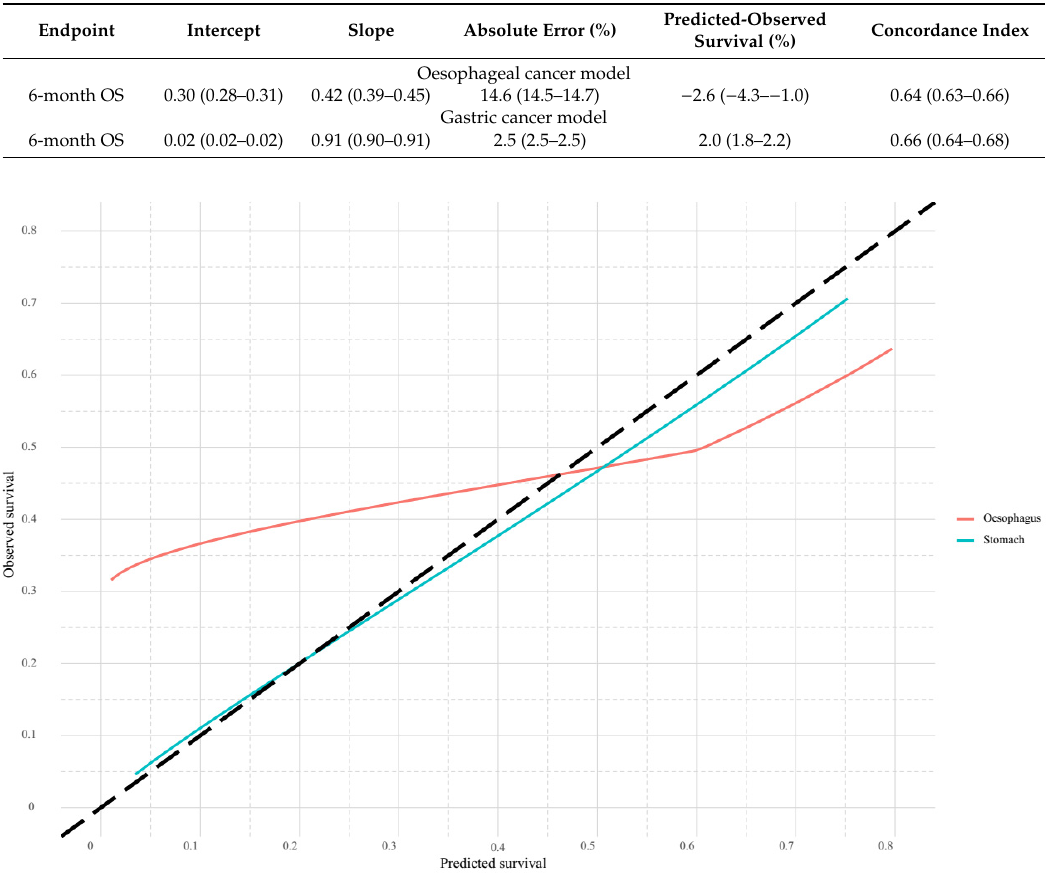
Figure 2. Calibration plot of predicted versus observed six-month overall survival for patients with oesophageal cancer (red line) and gastric cancer (blue line). oesophageal cancer (red line) and gastric cancer (blue Table 2. Calibration and discriminative ability of the entire cohort at six months survival.